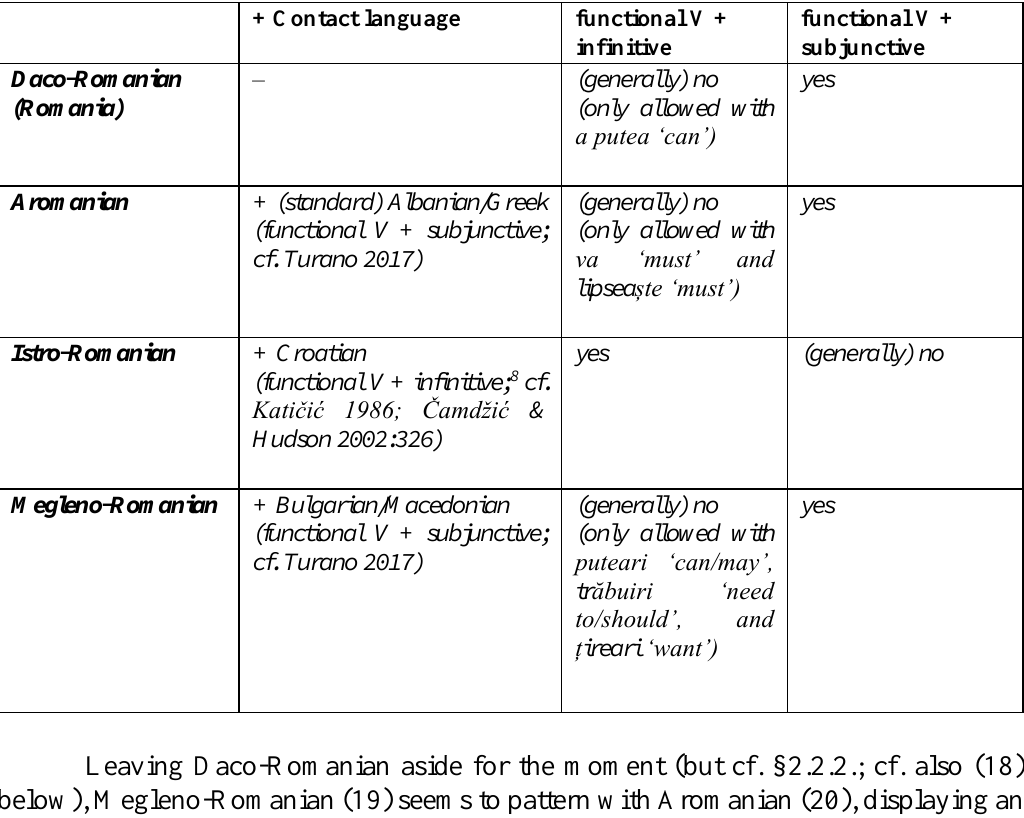
Table 1. Complex predicates within